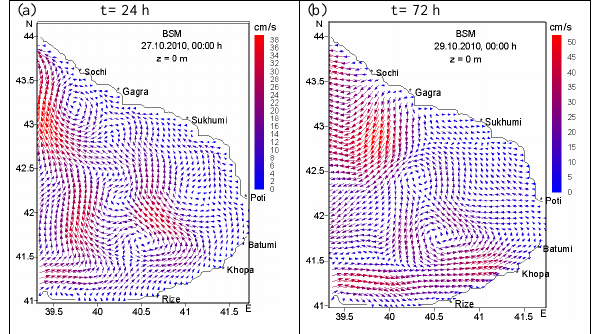
Fig. 14. The surface current fields predicted by RM-IG at 24 h (a) and 72 h (b) (the forecasting period is 26.10.2010, 00:00 h – 29.10.2010, 00:00 h).